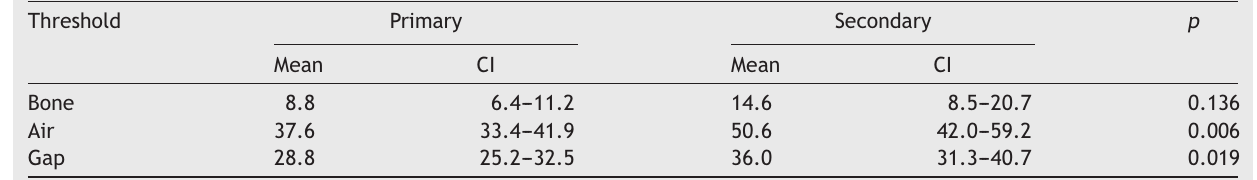
Table 5 Mean hearing thresholds (in dB) according to type of